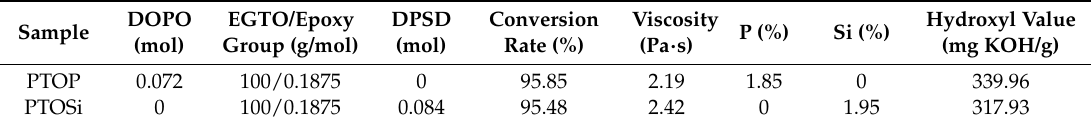
Table 1. The parameters of PTOP and PTOSi.